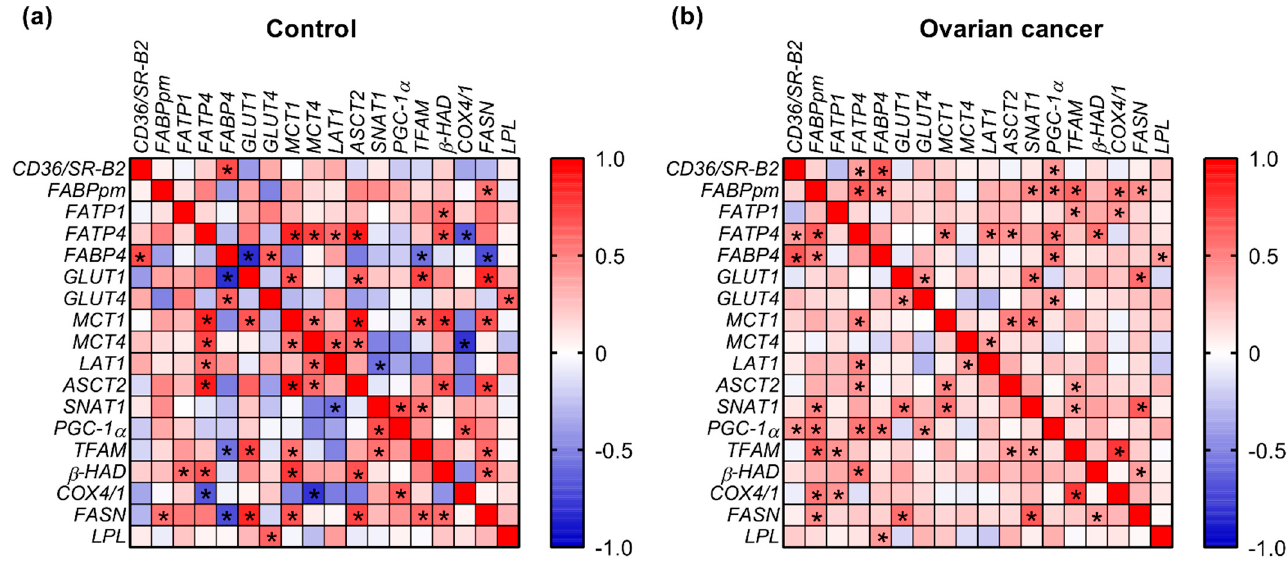
Figure 3. Heat map of correlations between the expression of energy substrate transporters and mitochondrial genes in ( a ) ovarian control and ( b ) cancer tissue. The relationships between the analyzed parameters were assayed via Spearman correlation coefficient. Correlations that were statistically significant ( p < 0.05) are indicated with an asterisk.